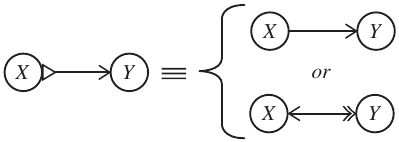
FIG. 5. Shortcut graphical notation for a direct cause from X to Y with or without a common